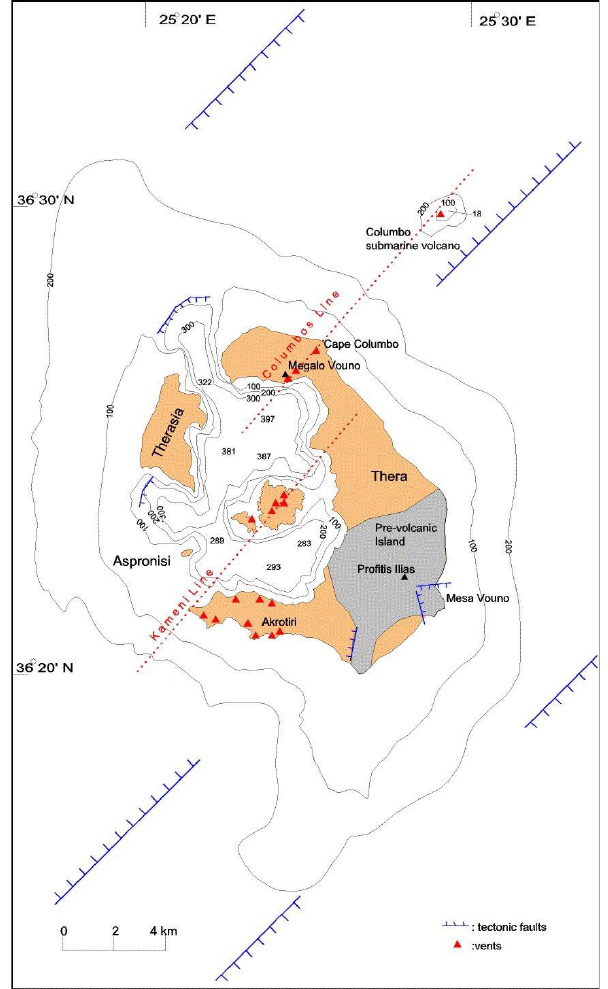
Fig. 1. Tectonic map of the Santorini volcanic island complex is comprised of five islands known as Thera, Therasia, Aspronisi, Palea Kameni, Nea Kameni and the Kameni and Columbo fault lines (after Heiken and McCoy, 1984).